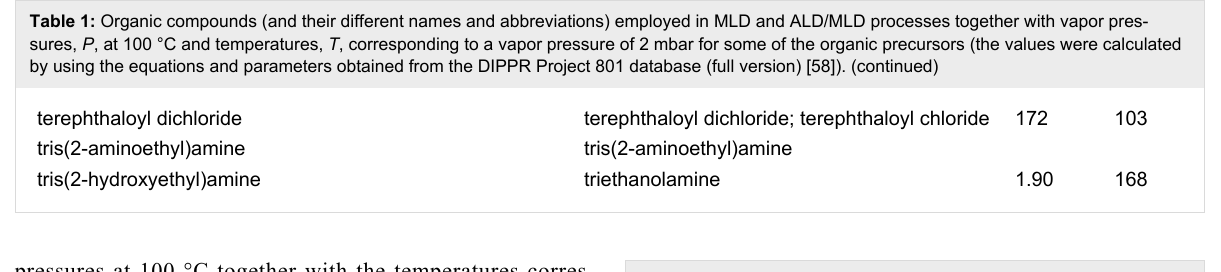
pressures at 100 °C together with the temperatures corres-